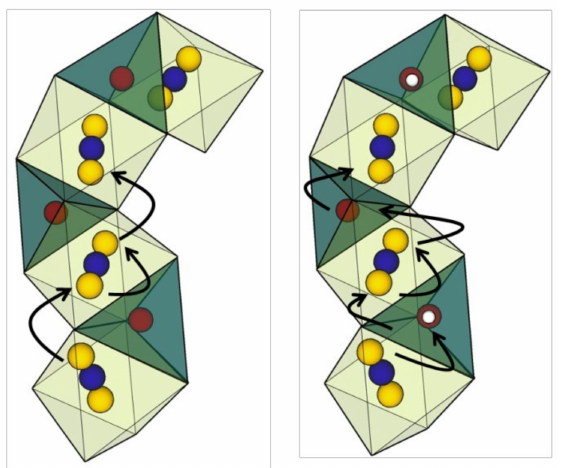
Figure 6. Diffusion pathways for Li + ions in the LLN sample (left) where Li + ions migrate between 96h octahedral sites, and in the LLN-Sm samples (right) where Li + ions migrate through 96h–24d– 96h–48g–96h–24d–96h chains due to the creation of vacant 24d sites after Sm 3+